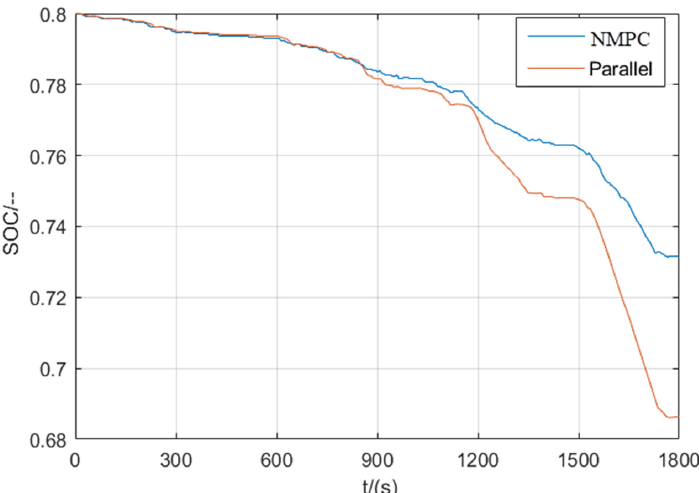
Figure 9. The battery SOC